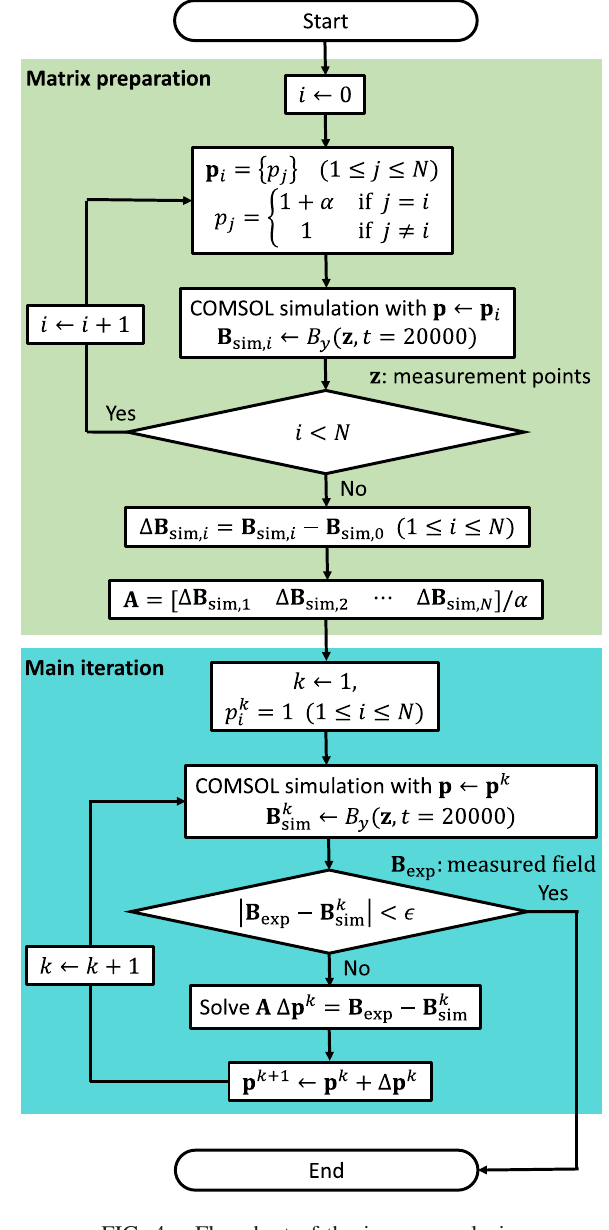
FIG. 4. Flowchart of the inverse